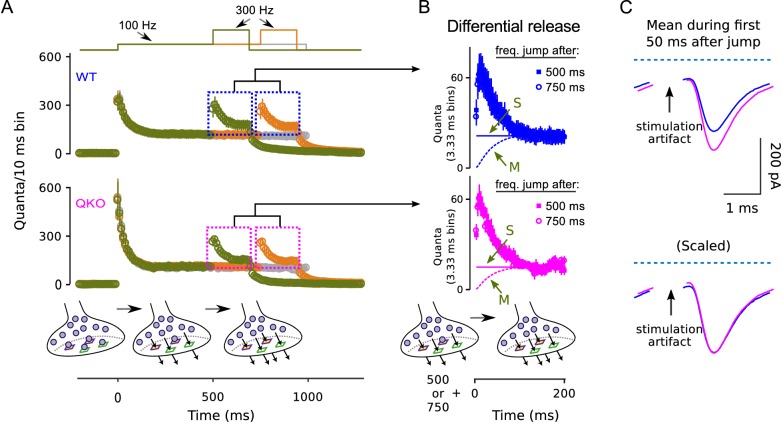
Frequency jumps from 100 to 300 Hz. (A) Analogous to Figure 5C. Displayed are results from three types of trials: one where the frequency of stimulation was increased to 300 Hz after 500 ms at 100 Hz (green); one where the increase to 300 Hz occurred after 750 ms of 100 Hz; and one where stimulation was maintained at 100 Hz throughout, all as diagrammed at top. Mean responses are quantified as the quantal content of sequential 10 ms segments, allowing direct comparison of the rate of release when stimulation was 100 to when 300 Hz; single segments contain quanta released by a single action potential for times when the stimulating frequency was 100 Hz, and three consecutive action potentials when the frequency was 300 Hz. Boxes demarcate responses used to calculate the differential release in (B). (B) Differential release calculated as for Figure 5D; ‘M’ and ‘S’ signify the same as in Figure 5D. Note that the amount of differential release after 500 ms of 100 Hz stimulation was equivalent to after 750 ms, confirming that 100 Hz stimulation drives the standing fullness of the RRP to a steady state. (C) Average of traces during first 50 ms after jump to 300 Hz after 500 ms of 100 Hz stimulation. Blue is WT, magenta is QKO. Dashed light blue lines are baseline.Alternate scenario: We use the results in Figure 5 and here to conclude that the probability of release of low pv vesicles is elevated at QKO synapses. We have additionally considered the alternate scenario where the low pv vesicles are not immediately releasable (Miki et al., 2016; Gustafsson et al., 2019). In this case, the ongoing synchronous transmitter release occurring after eliminating high pv vesicles could be explained by a fast recruitment mechanism that would transfer a tiny fraction of the vesicles from the un-releasable state to a releasable state in the time between action potentials. The fraction would be the value of p¯v for the low pv vesicles. However, this alternate scenario is not compatible with the results of the frequency jump experiments because the acceleration mechanism could not influence the rate of transfer from the un-releasable to releasable state until after the first 3.33 ms interstimulus interval during 300 Hz stimulation. In contrast, the rate of transfer during the first 3.33 ms interstimulus interval would have to be equivalent to the rate during the first 3.33 ms of the 20 or 10 ms interstimulus intervals during the preceding 50 or 100 Hz stimulation. Therefore, one would expect 6-fold or 3-fold fewer new releasable vesicles at the end of the first 3.33 ms interstimulus interval compared to before the preceding action potential. If so, the second pulse during 300 Hz stimulation would elicit paired-pulse depression rather than the robust facilitation seen in Figure 5D and (B). And, indeed, one would expect twice as much paired-pulse depression in Figure 5D compared to in (B) (i.e. because the transfer rate during 50 Hz stimulation would be half the rate when stimulation is 100 Hz).